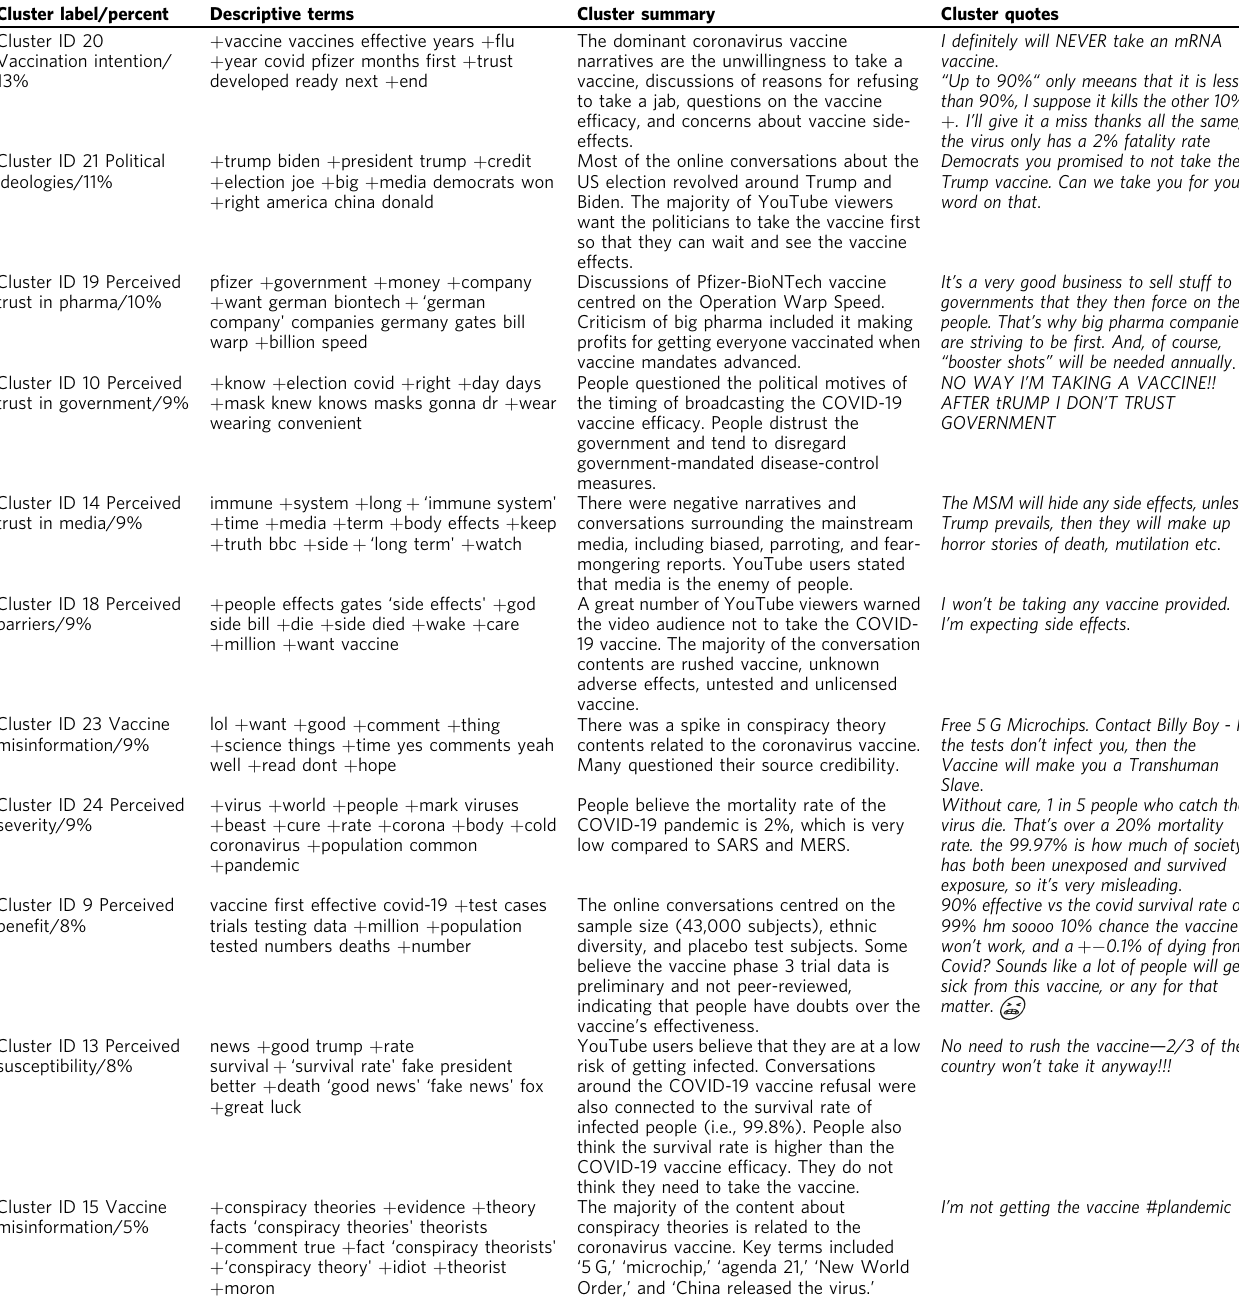
Table 4 Summary of text cluster